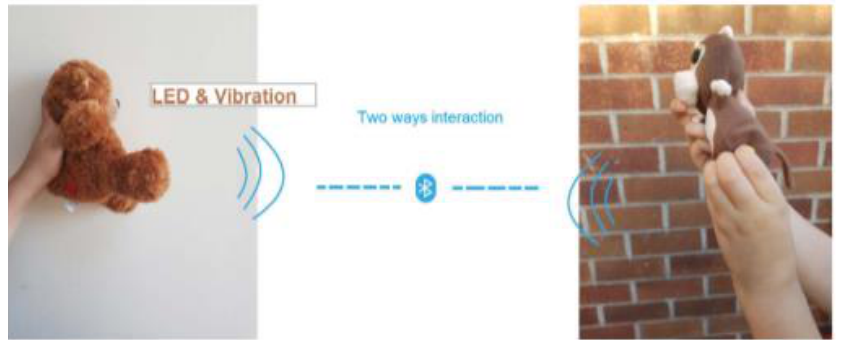
Figure 18. Two children playing with TangToys [36].